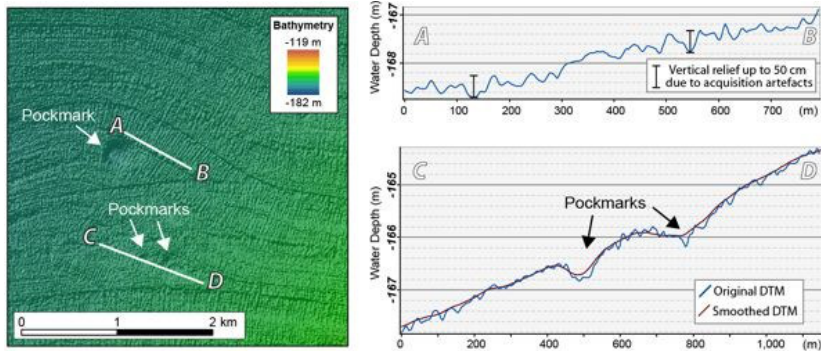
Figure 5. Left: Detail of the Malin Basin dataset, illustrating the impact of artefacts on the dataset. Right: (Top) Bathymetric profile from ( A ) to ( B ). (Down) Profile from ( C ) to ( D ) across the original dataset and the smoothed bathymetry.